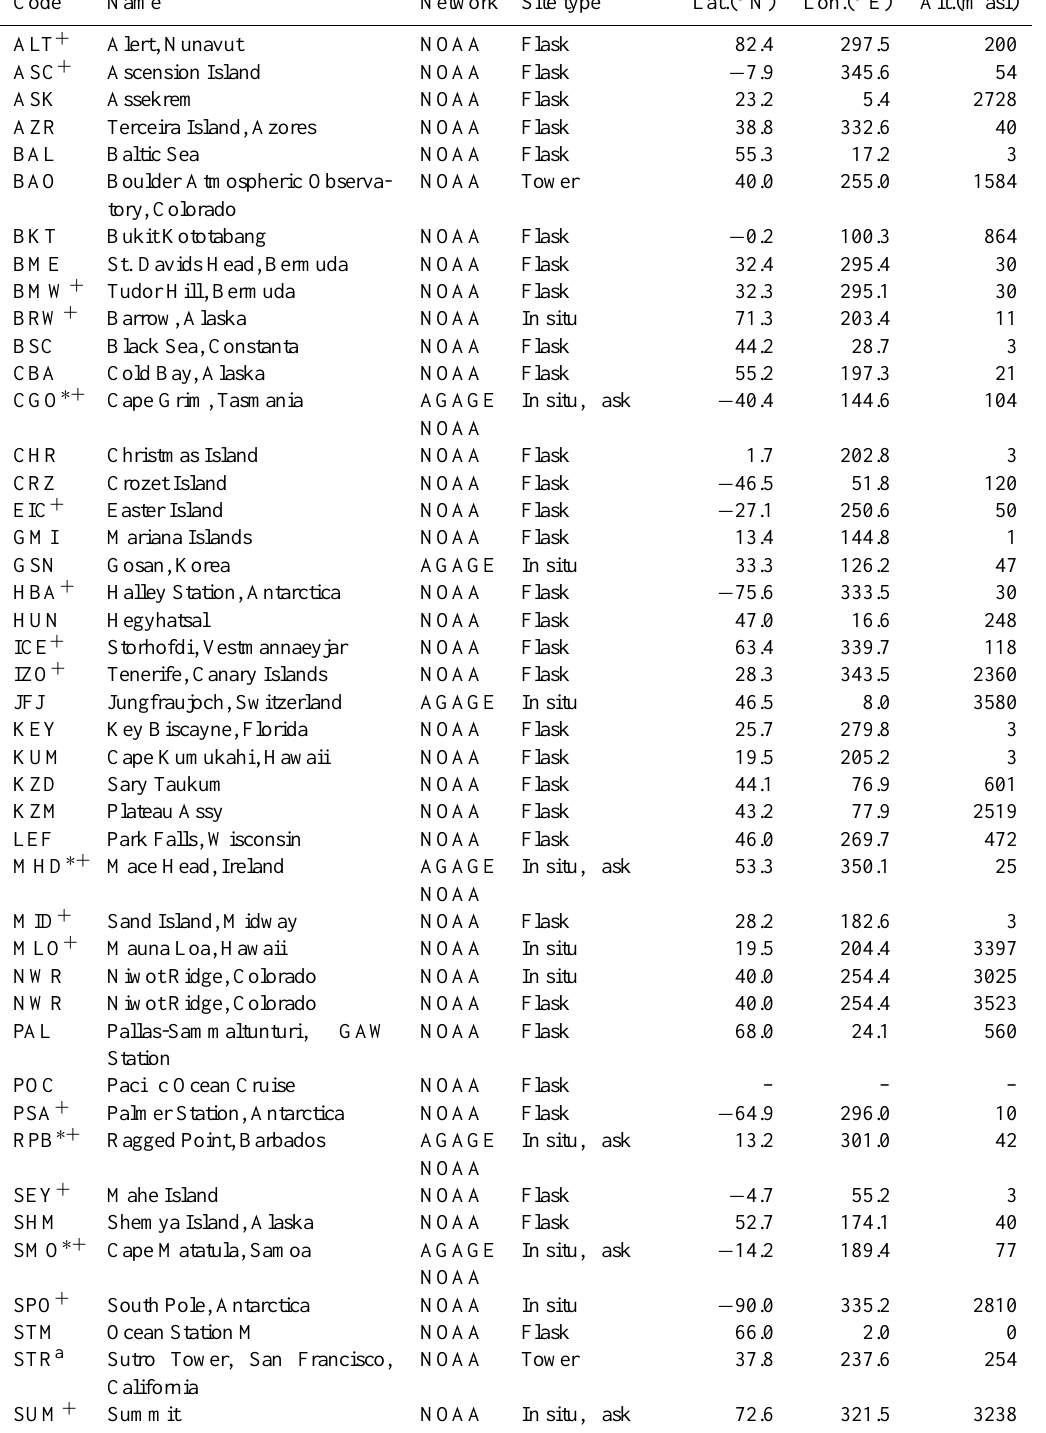
Table 1. Site identification codes, names and locations. An asterisk (*) in the first column denotes a site used in the AGAGE-only global inversion, and a plus (+) denotes a site used in the AGAGE-NOAA global inversion. All sites are used in the regional